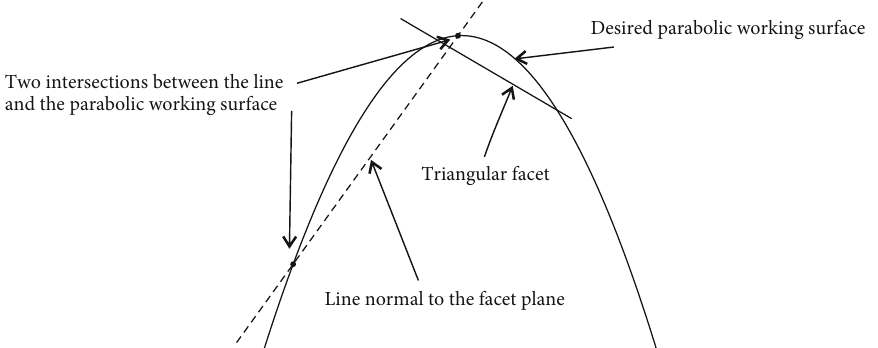
Desired parabolic working surface Triangular facet